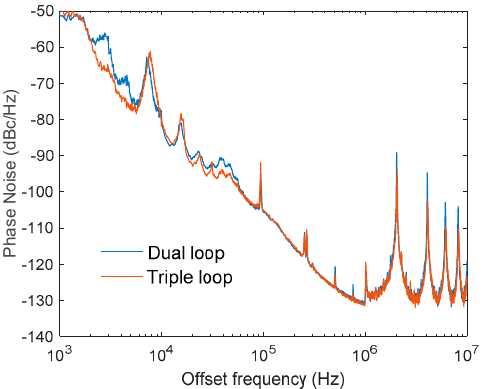
Figure 10. Experimental phase noise spectrum of a multi-cavity optoelectronic oscillator using a 20- m seven-core fiber comparing dual- and triple-loop Vernier configurations [59].